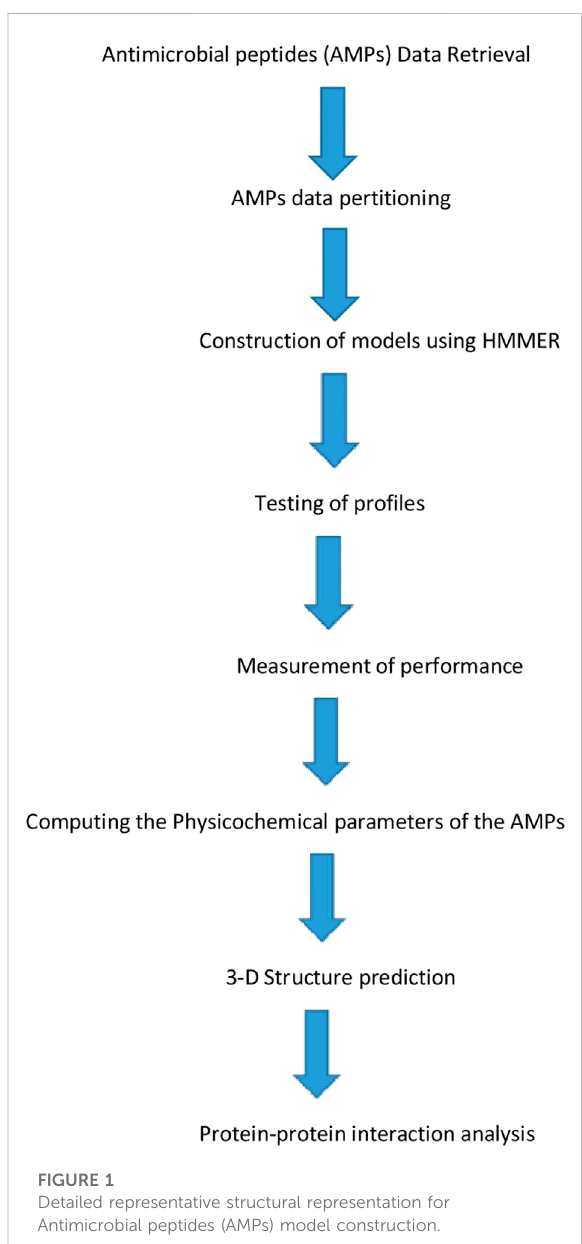
pro fi les on an independent AMP dataset. Figure 1 below shows the detailed representation of AMPs model construction.